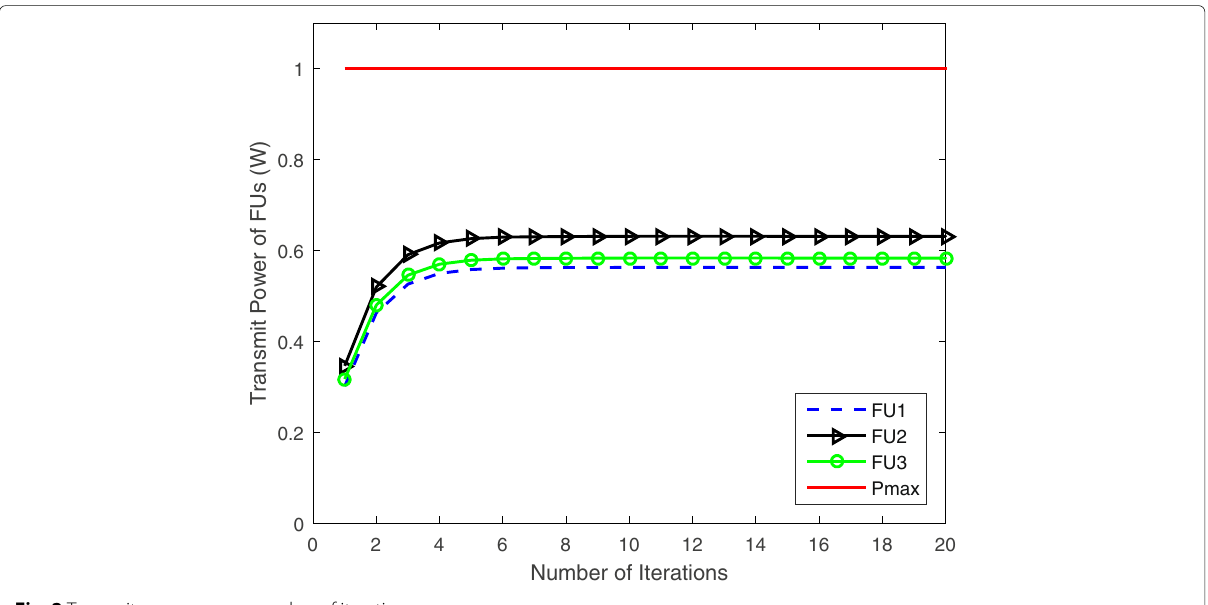
Fig. 2 Transmit power versus number of iterations